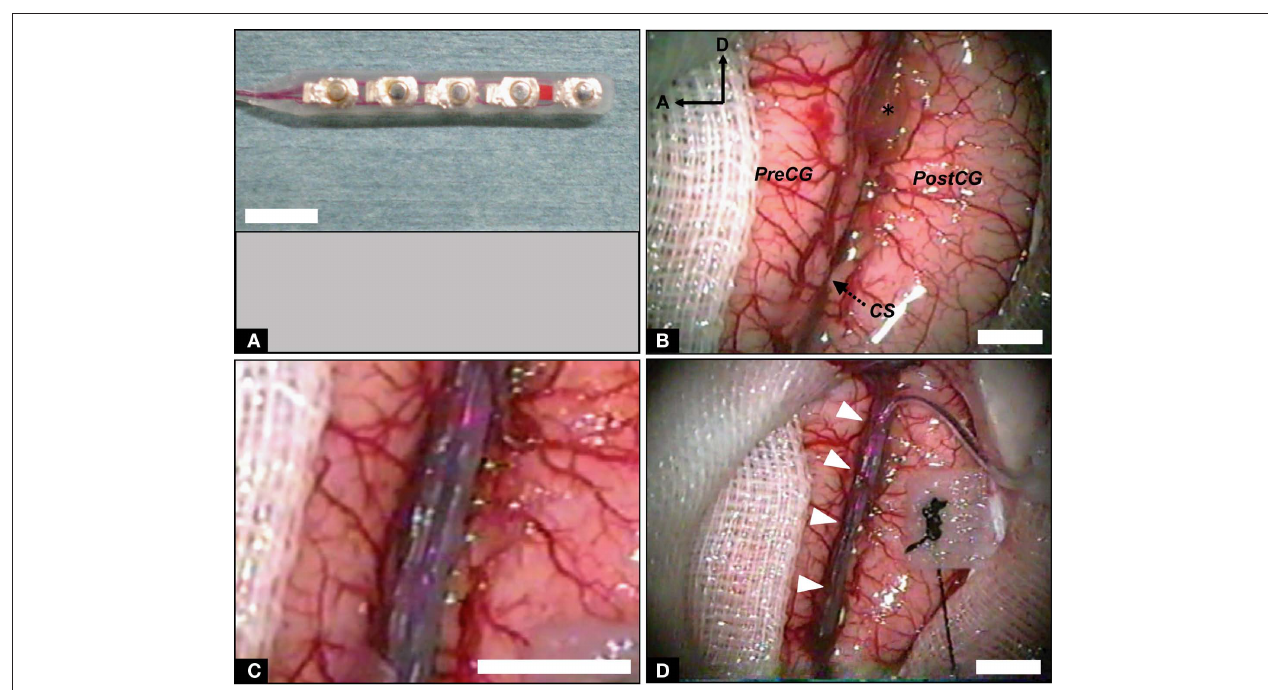
lateral sulcus. (C) High-magnification view of probe branches fitted to STS and ITG. (D) Low-magnification view of the left temporal lobe following implantation of electrode array. White arrowheads indicate probe branches inserted into STS. Black arrowheads denote branches on the surface of the STG. Scale bars indicate 5 mm.